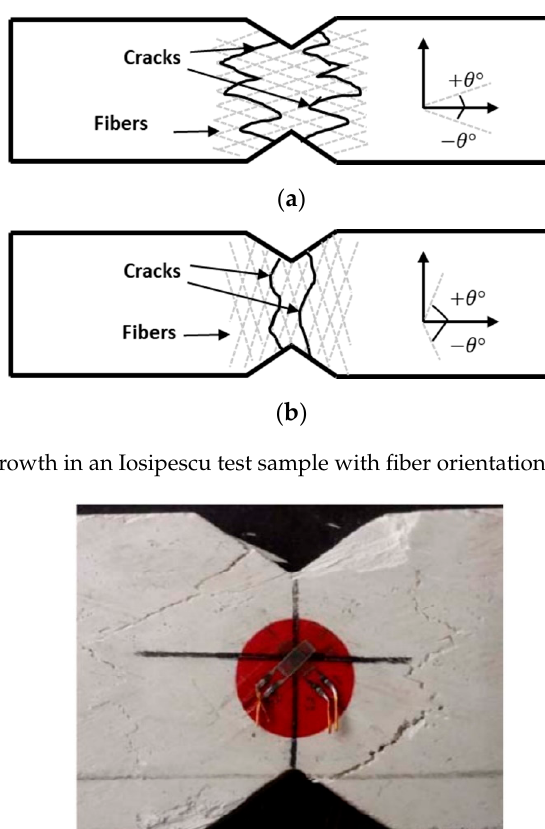
Table 5. Damage limits for stress-based Tsai-Wu failure criterion.